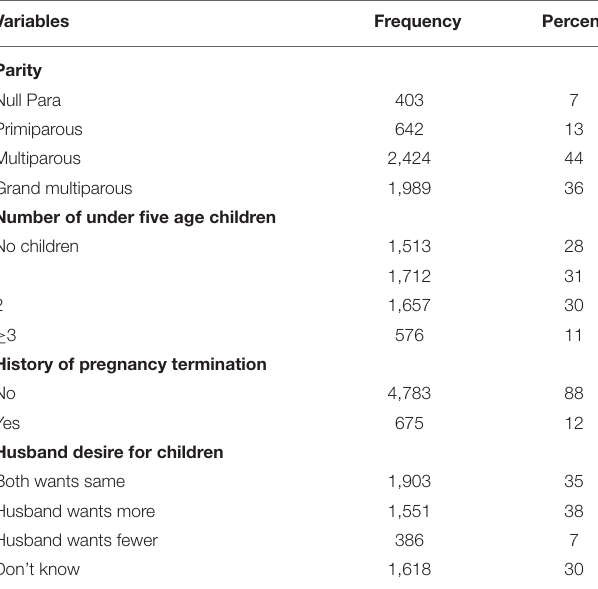
TABLE 3 | Obstetrical related characteristics of participants in